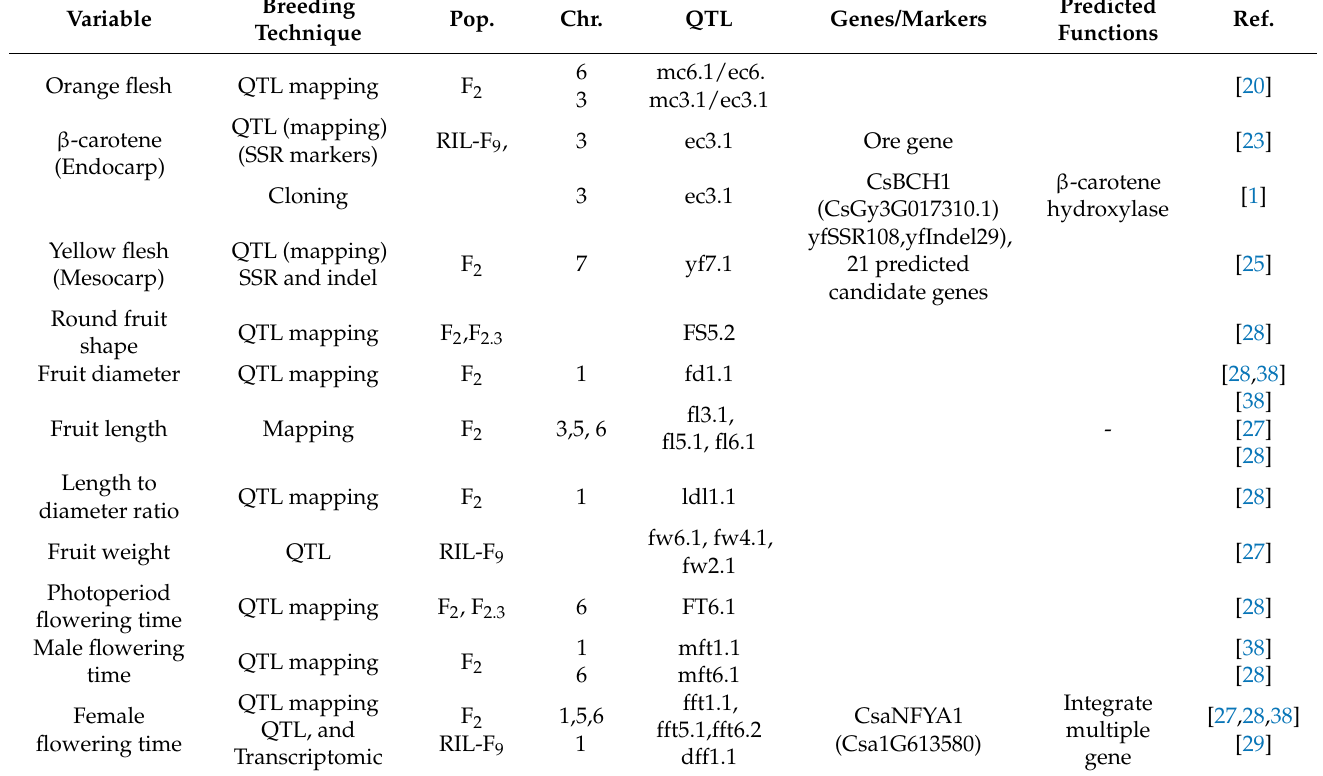
Table 1. Quantitative trait loci (QTL) of Xishuangbanna cucumber fruit quality and flowering-related